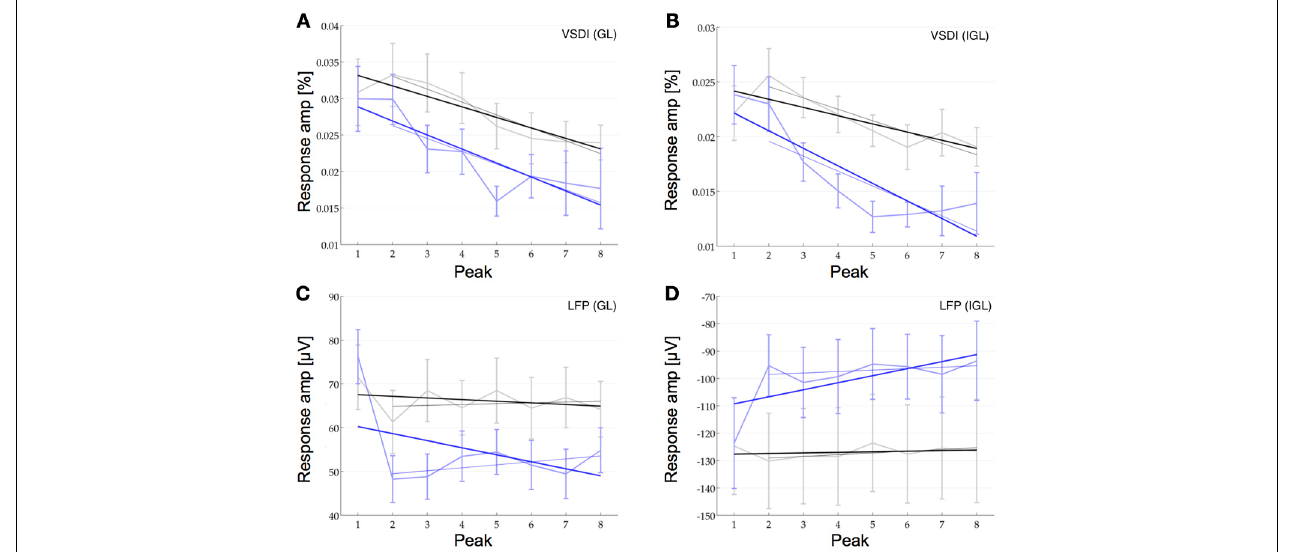
FIGURE 5 | Short-term plasticity at the population level. The response amplitude of the individual peaks at 40Hz (black) and at 80Hz (blue) compared to their relative baseline are plotted for the VSDI response in the GL (A) and the IGL (B) and for the LFP in the GL (C) and the IGL (D) (note the negative y-axis in D !). Linear curve fitting over all eight pulses shows depression in all four plots (thick lines with negative